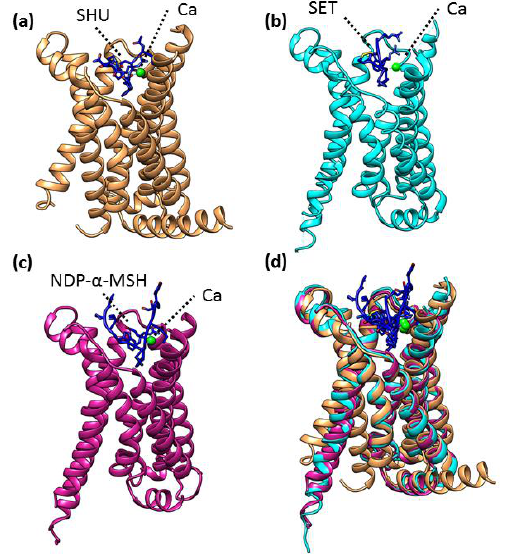
Figure 2. Sequence and structural conservation of MCRs : ( a ) Multiple sequence alignment of proteins in the MCR family, highlighting the high sequence conservation among the members. Identical amino acids are shown in red while similar amino acids are shown in blue. ( b ) Analysis of the evolutionary conservation of human MC4R sequence conservation using ConSurf (https://consurf.tau.ac.il/). The color-coding bar represents the coloring scheme of the conservation score: e — an exposed residue; b — a buried residue; f — a predicted functional residue (highly conserved and exposed); s — a predicted structural residue (highly conserved and buried).